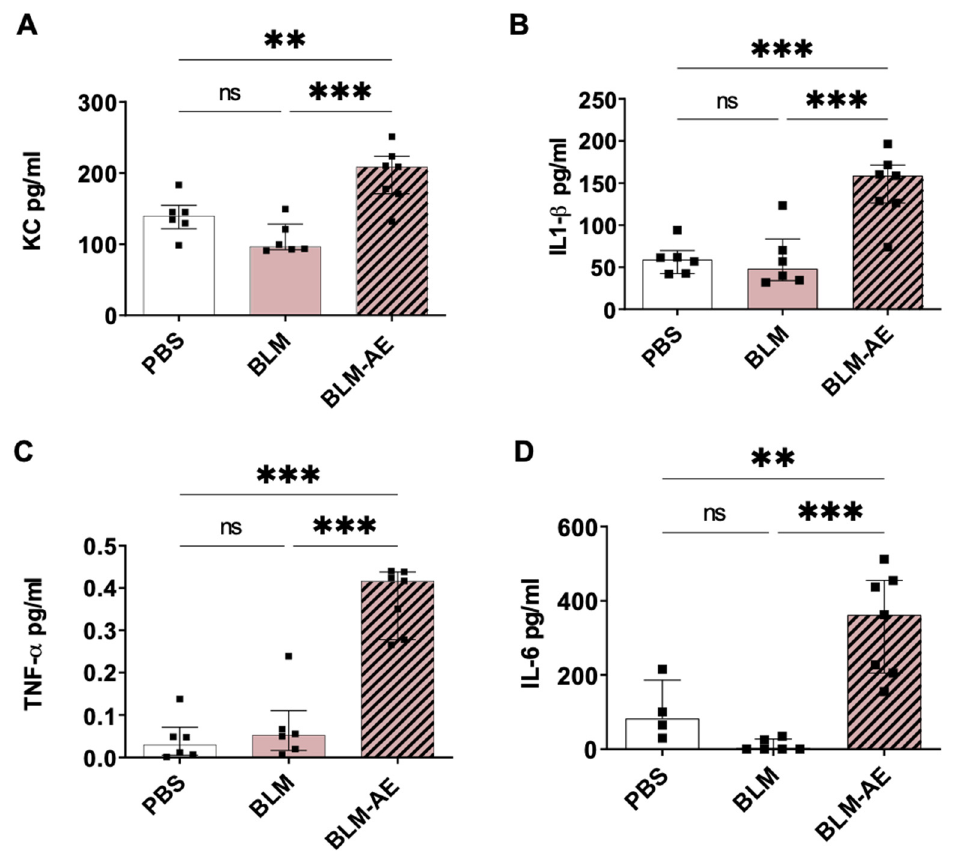
Figure 6. Quantification of pro-inflammatory cytokines in whole lung extracts: Quantification of KC ( A ), IL-1 β ( B ), TNF- α ( C ) and IL-6 ( D ) pro-inflammatory proteins in whole-lung protein lysates from the control PBS group (white bar), BLM group (pink bar) and BLM-AE group (pink hatched black bar). All values are represented as median ± interquartile range; one-way ANOVA analysis followed by Newman–Keuls was performed. ns: not significant, ** p ≤ 0.005, *** p ≤ 0.001.